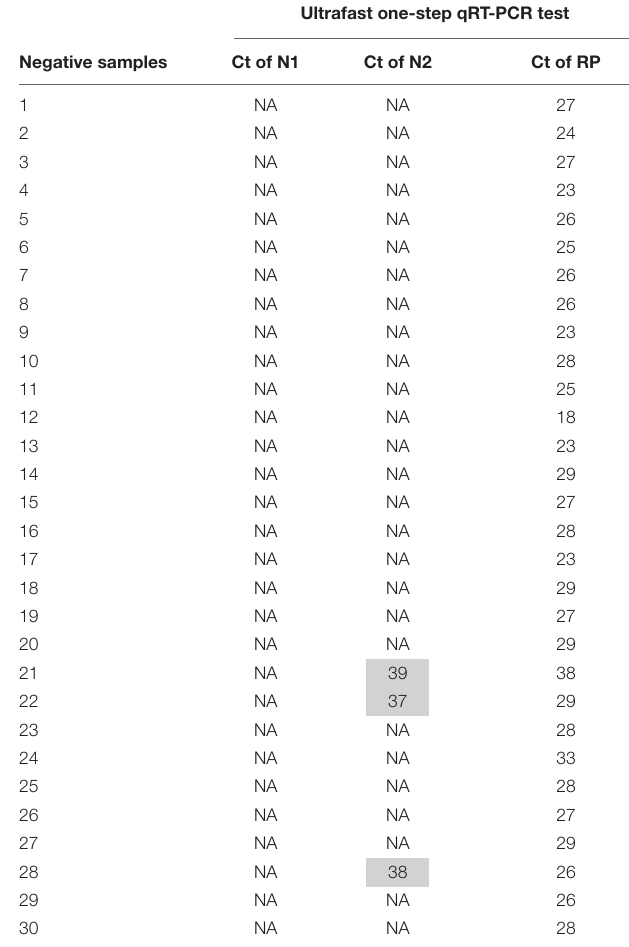
TABLE 3 | Cycle threshold (Ct) value of SARS CoV-2 positive samples of ultrafast one-step qRT-PCR in comparison to an FDA approved test “Xpert R (cid:13) Xpress SARS-CoV-2”.